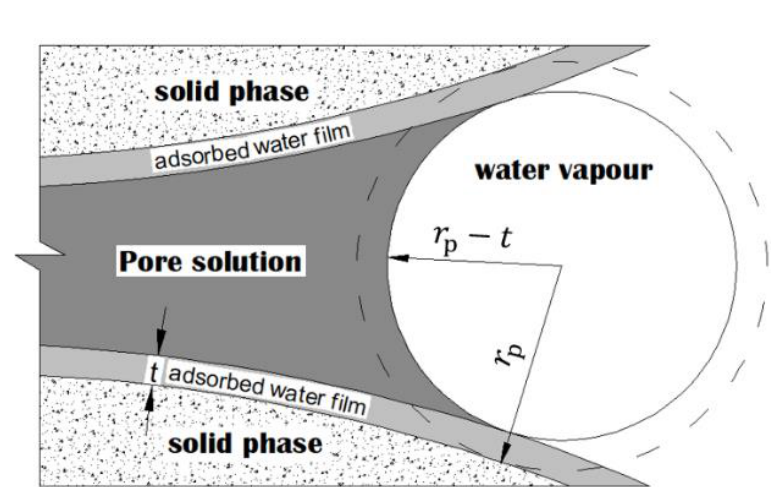
Figure 1. Schematic illustrations of meniscus curvature and adsorbed water film in capillary pores.